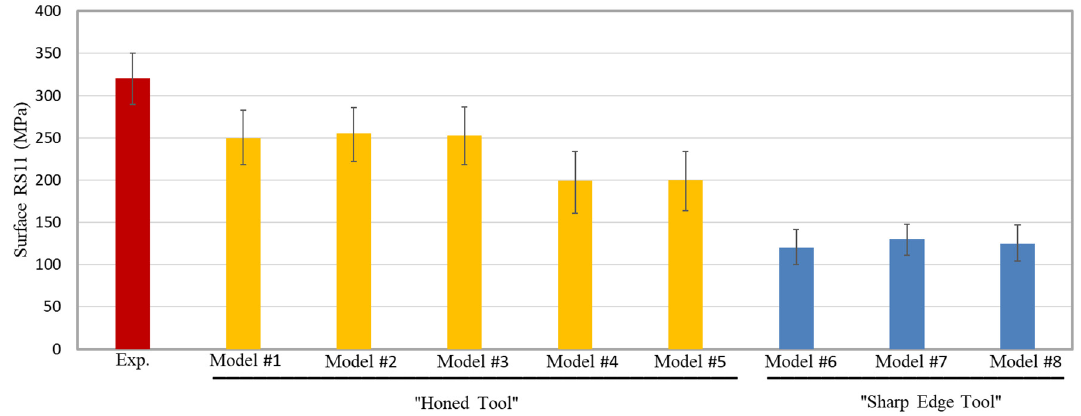
Figure 6. Surface RSs in the cutting direction (RS11)—experimental (exp.) vs. FEA. The temperature-independent damage evolution models (Model #2 and Model #3)